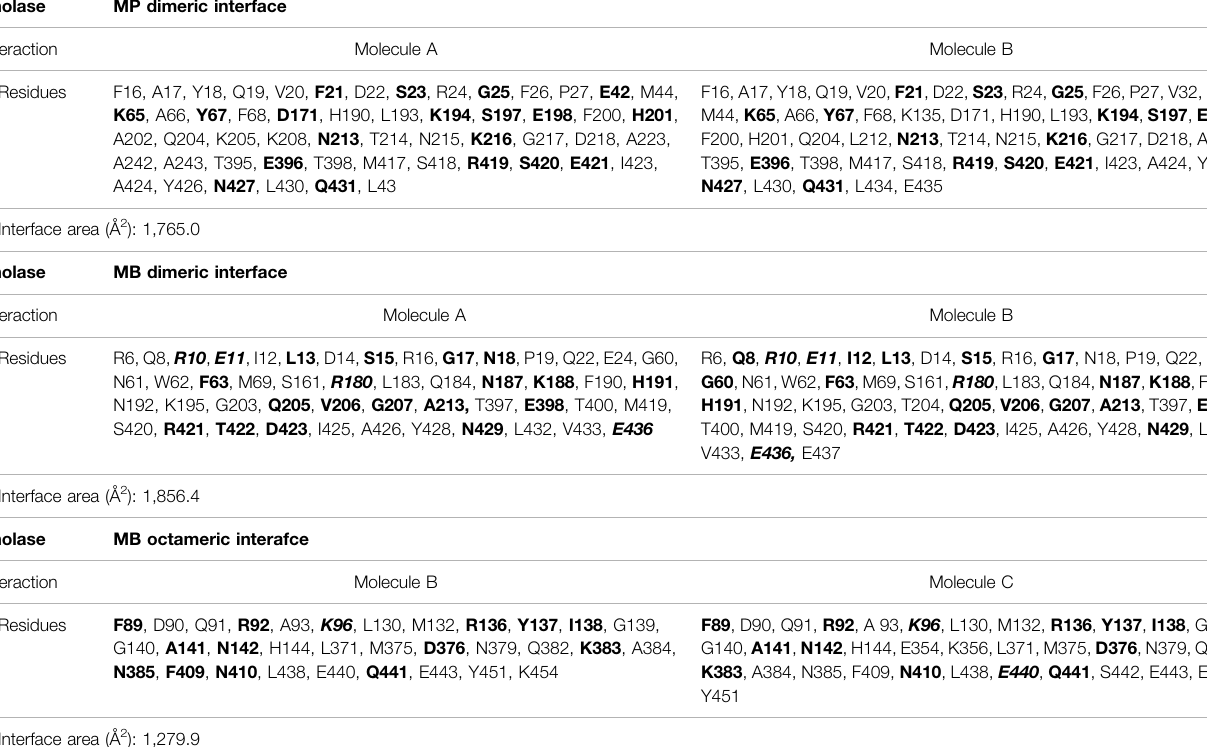
TABLE 1 | The interactions and amino acids between two chains for the formation of different types of enolase interfaces.